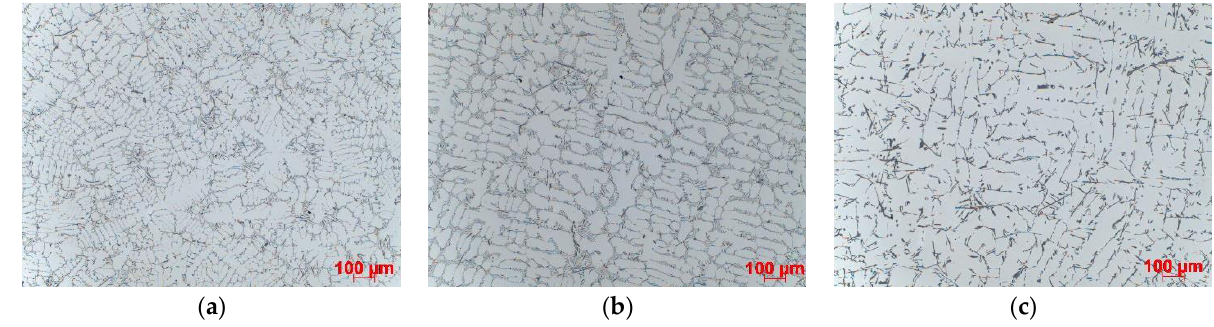
Figure 4. Dispersion of dendritic structure in casting made in Sand No. 1, etched with HF, 100 × magnification: ( a ) die, ( b ) ablation, ( c ) sand mould.